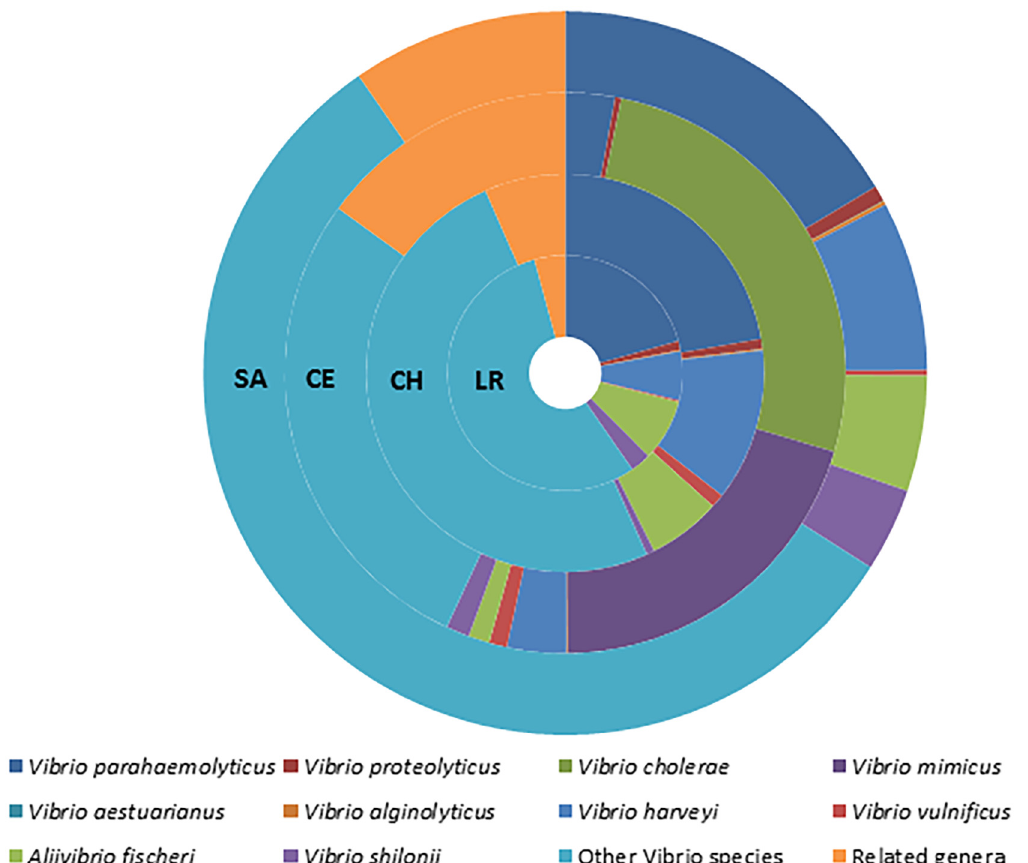
Fig 5. Taxonomic structure of the genus Vibrio in the four coastal lagoons studied: Rosada lagoon (LR) Chelem (CH); Celestun (CE) and Sabancuy (SA).